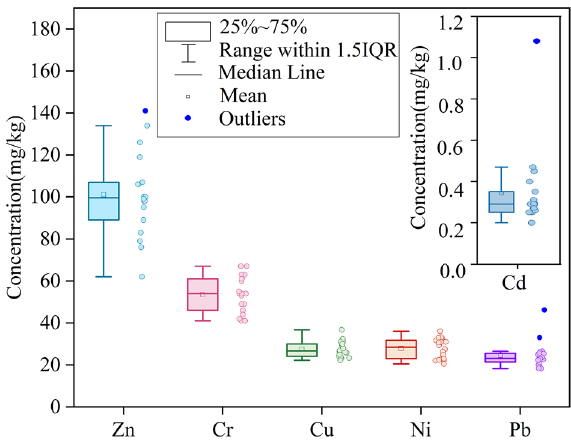
Figure 4. Concentrations of HMs in the topsoil of the study